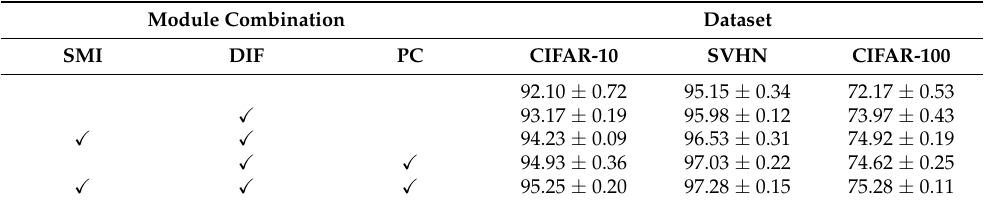
Table 4. Ablation study on MACP with different module combinations, test accuracy (%) of each setting on CIFAR-10/100 and SVHN are